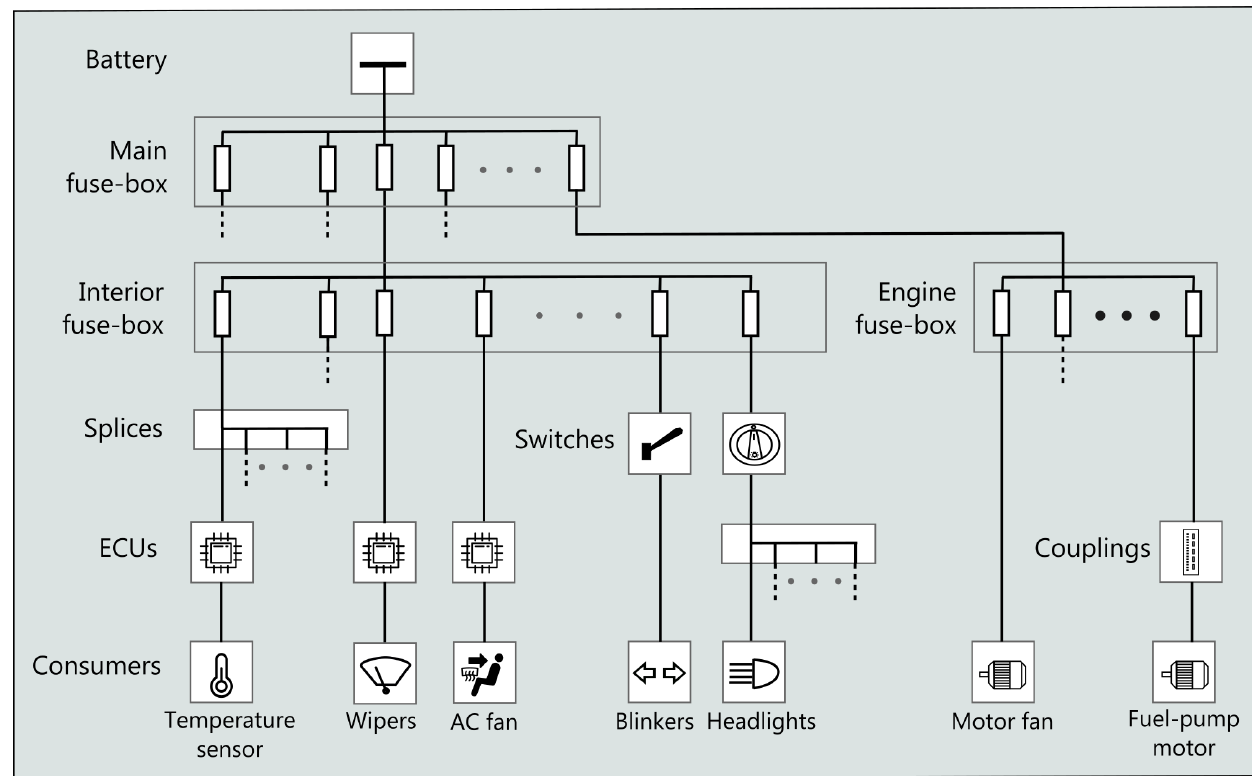
Figure 4. Simplified electrical topology of vehicular